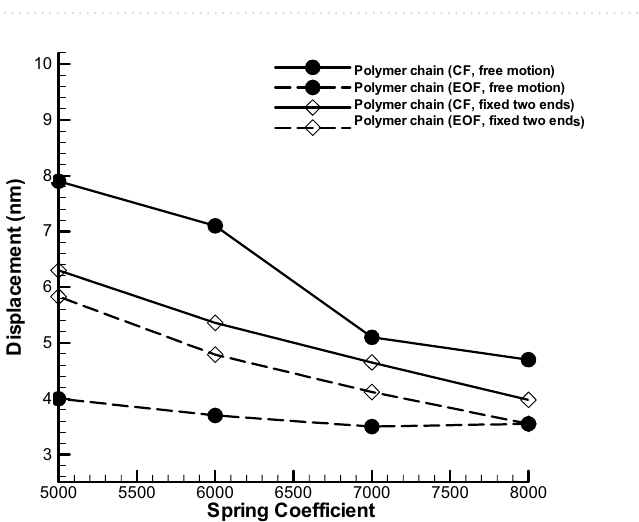
Figure 8. Changes in gyration radius ( a,b ) and velocity correlation function ( c,d ) over time for restricted movement of the polymer chain in different spring stiffness (bond coefficient) states and different external forces (n = 50).